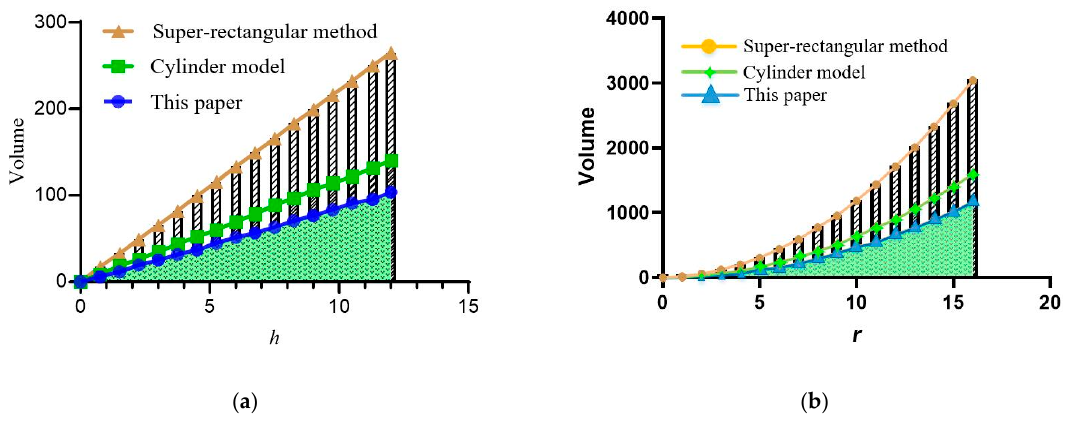
Figure 6. Different model volume comparisons: ( a ) model volume at different heights and ( b ) model volume at different radii.